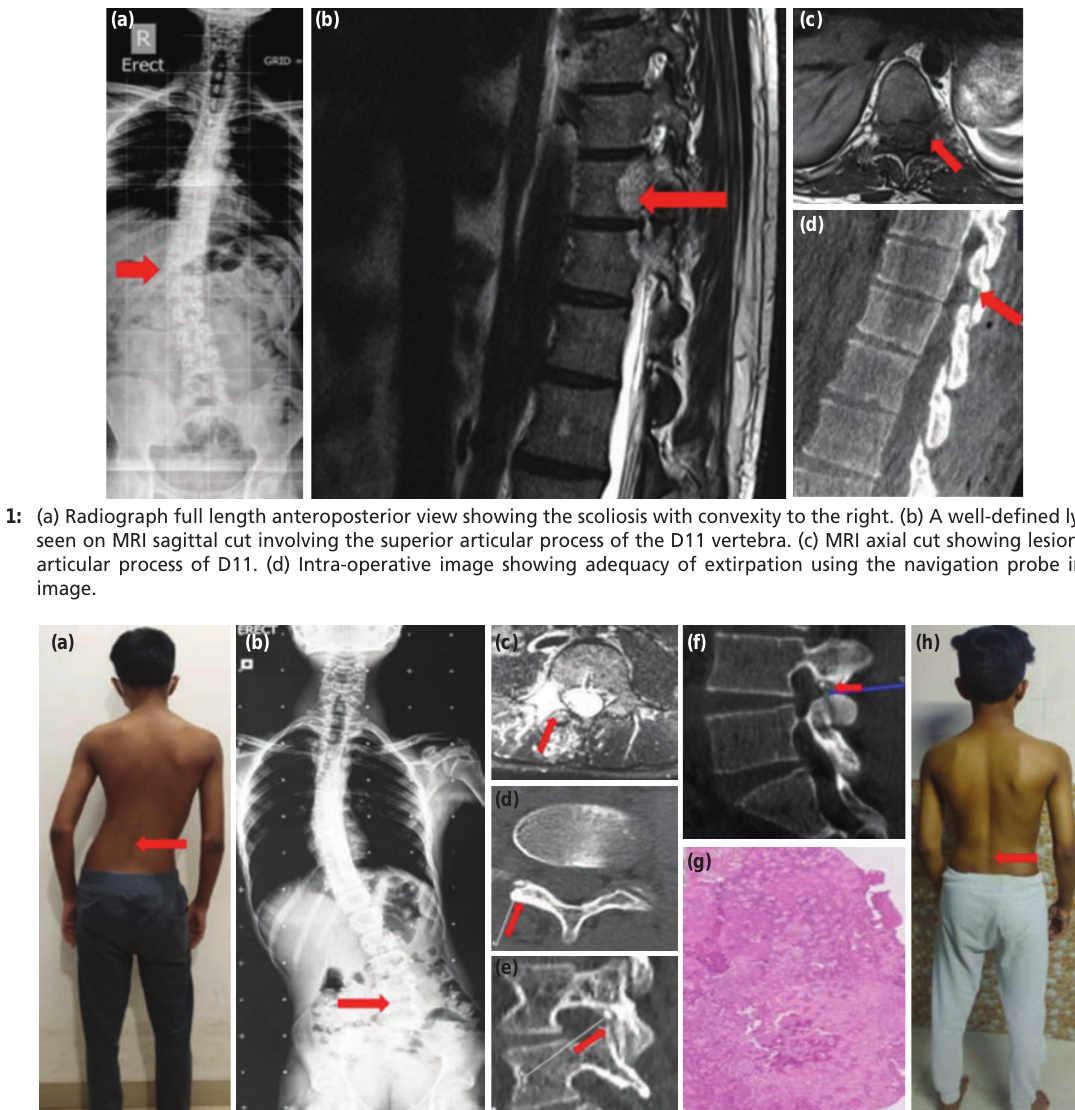
(a) Clinical examination shows lumbar scoliosis with convexity to left. (b) Radiograph full length anteroposterior view showing Fig. 2: lumbar scoliosis with convexity to the left. (c) Lytic lesion with marrow edema and enhancement focus involving the L4 right pars interarticularis seen on MRI axial cut. (d) A well-defined nidus with radiolucency and central sclerosis seen on axial cut on CT scan. (e) A well-defined nidus seen at pars interarticularis on sagittal cut on CT scan. (f) Checking the adequacy of extirpation using the navigation probe. (g) Histopathological examination confirmed diagnosis of osteiod osteoma. (h) Six months follow- up clinical picture showing correction of lumbar